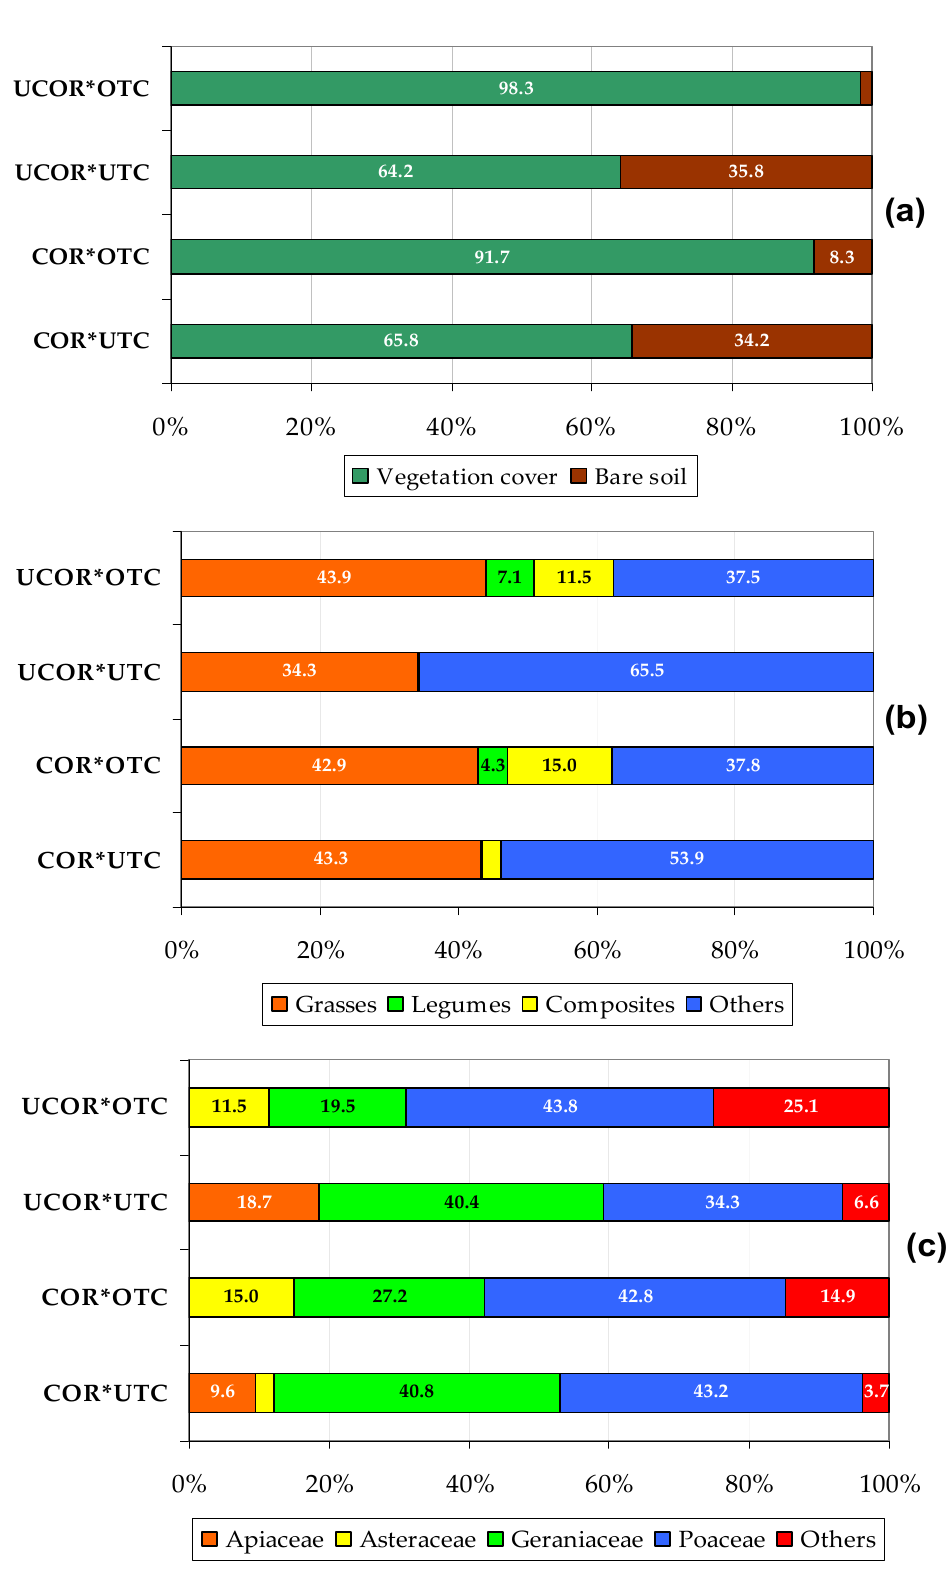
Figure 9. Pasture characteristics of the experimental field in spring 2020, in amended (COR) and unamended areas (UCOR), under tree canopy (UTC) and outside tree canopy (OTC): ( a ) vegetation cover (%); ( b ) floristic composition by groups; ( c ) floristic composition by families.